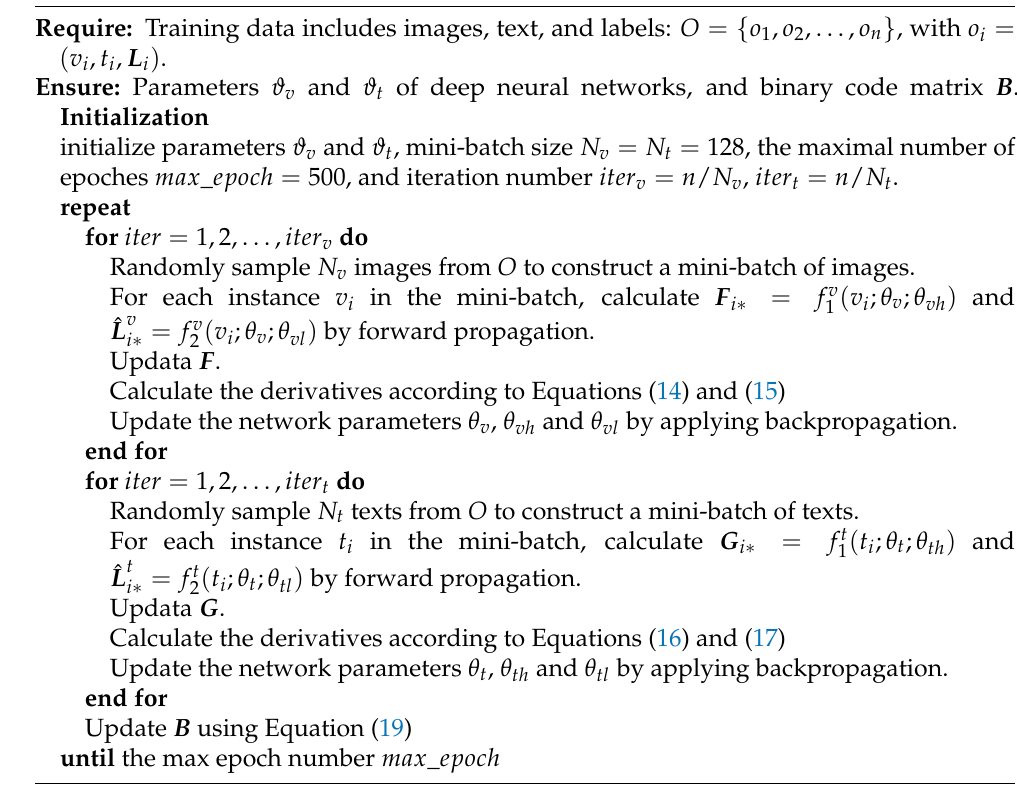
Algorithm 1 The learning algorithm for